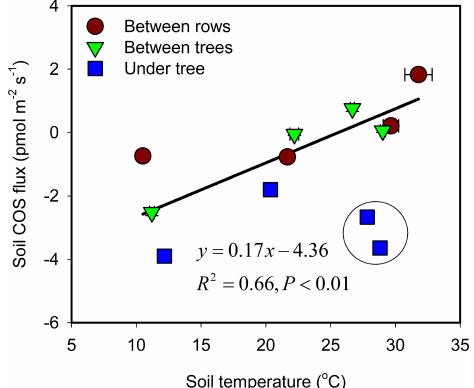
Figure 2. Relationship of soil COS flux and soil moisture. Each data point represents the diurnal average ( N = 24) for each micro-site and season (measurement campaign). Error bars represent ± 1 SE around the mean; errors for flux are about the size of the symbols.